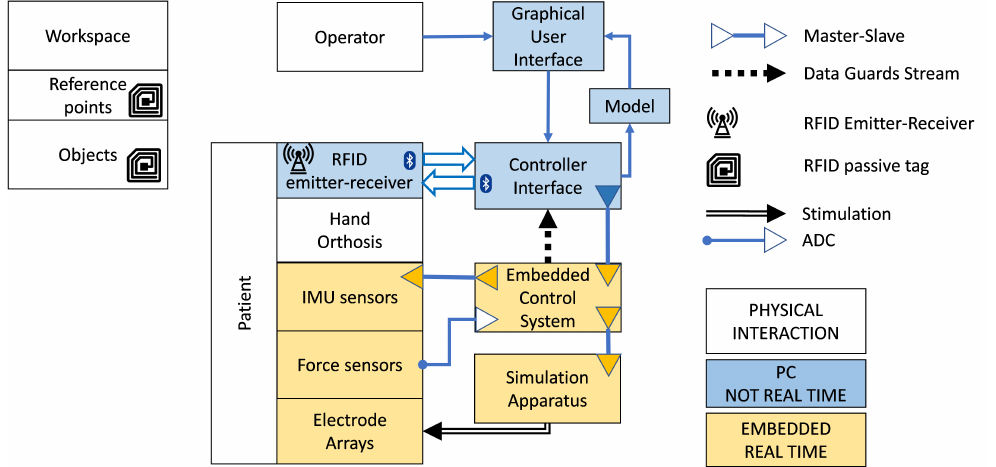
Figure 1. Architecture of the system. The prototype operates in three different domains (i) envi- ronmental interactivity (white), (ii) non-real-time control (teal), and (iii) real-time control (yellow). Devices in the real-time domain operate synchronously at fixed frequency with no jitter. Non real- time components operate at different frequencies aimed at giving a sensation of responsiveness but absence of jitter is not guaranteed. The controller interface (CI) operates as an exercise controller, logger, GUI for operators, and information broker from objects (Bluetooth) and RealTimeData. A multilayer master–slave architecture combines non-real-time components (CI) with real-time compo- nents managed by the Embedded Control System (ECS). ECS and CI share data and commands with a custom instruction set over UDP. The ECS controls the set of IMUs via I2C, and the stimulation apparatus via Virtual COM Port, and an on-board ADC for sampling grasp forces. Environmental interactivity is dependent on synchronous real-time information and control fed at 40 Hz (hand kinematics, thumb contact force, and pulse by pulse stimulation), and non real-time information (3–5 Hz) from RF passive